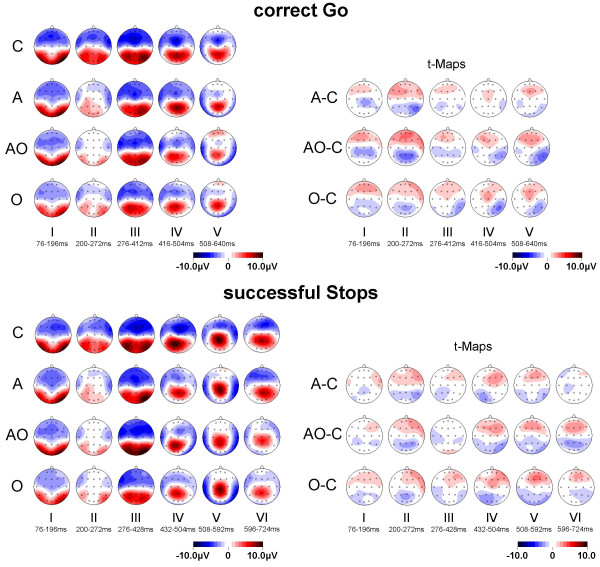
Microstate-maps and t-maps for correct Go and successful Stop-trials. Spline-interpolated microstate-maps for normal controls (C), children with AD/HD (A), ODD/CD (O) and AD/HD+ODD/CD (AO) and additional exploratory t-maps with comparisons of clinical groups vs. controls. Unadjusted two-tailed significance-level is reached at t(17 to 21) > 1.7 p < .05.